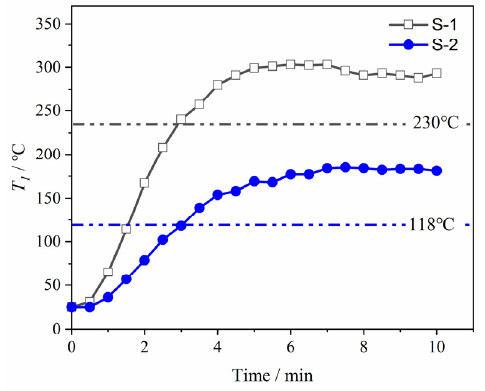
Figure 11. Thermal insulation performance of the lattices after compressive failure.